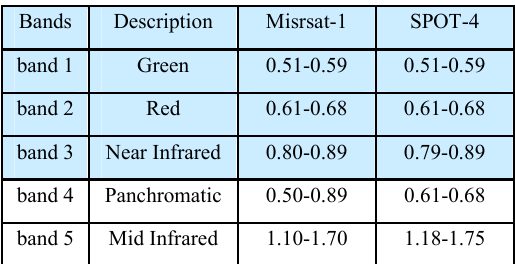
Table 1: The Spectral Resolutions (µm) of the Egyptsat-1 and The SPOT-4 Data